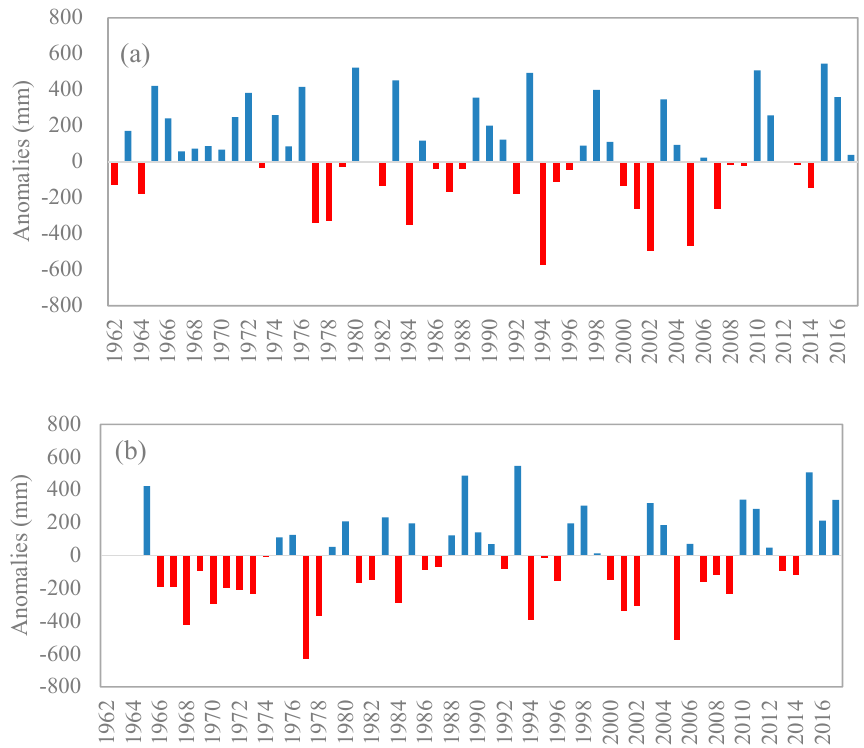
Figure 3. Annual time series of precipitation anomalies relative to the average value from 1981 to 2010 at ( a ) Kyoto station and ( b ) Kumogahata station in the Kamo River